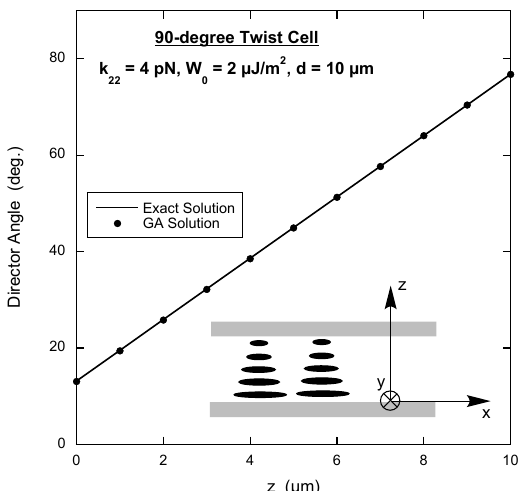
Figure 3. Director angle for the 90-degree twist cell. Inset: schematic of the cell. The director angle is measured from the x -axis in the xy-plane. Black circles: genetic algorithm results; black line: exact